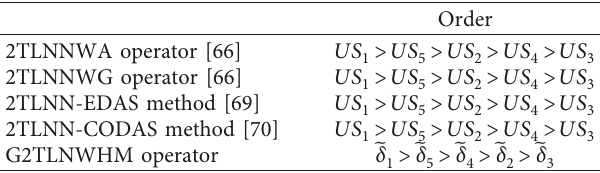
Table 6: Order of the university students.